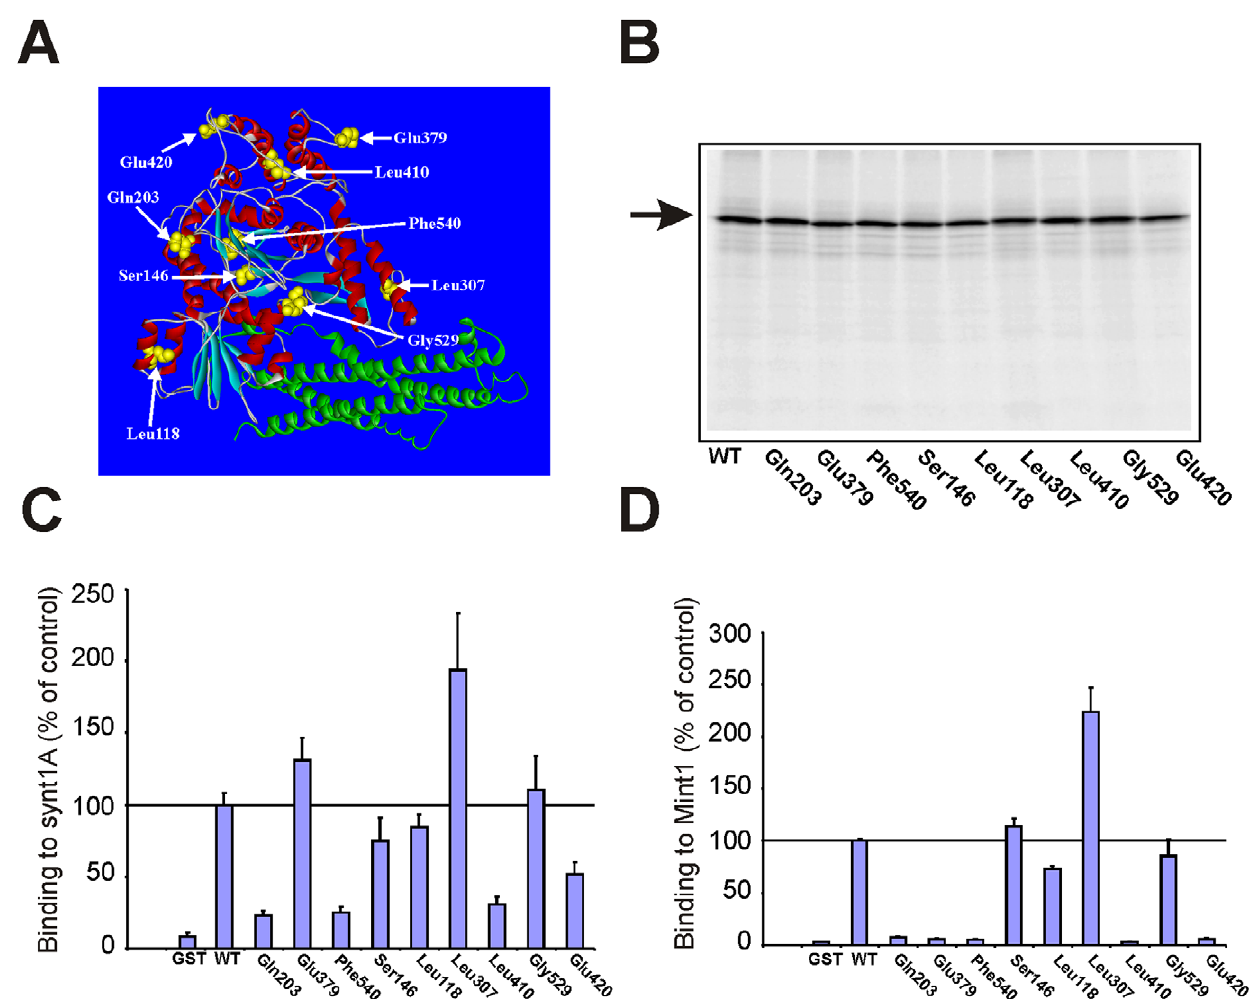
Figure 1. Biochemical phenotype of transposon insertion mutants of Munc18-1. (A) Structure of Munc18-1 indicating the position of the insertion mutations. Nine distinct full-length mutants were created randomly distributed throughout the Munc18-1 protein structure. For each mutant, five amino acids were inserted at the specified location (for the amino acid sequence of each exact insertion see Table 1). Arrows designate the position of the last unchanged amino acid for each insertion mutation. (B) 35 S-radiolabelled Munc18-1 insertion mutants were produced by an in vitro transcription-translation reaction and separated by SDS-PAGE. Amount of protein made for wildtype (Wt) and mutant Munc18-1 were verified by autoradiography as indicated by the arrow. Note that none of these insertion mutations affected protein expression. Radiolabelled Munc18-1 proteins from part B were then assessed for binding to GST-syntaxin (C) and GST-Mint1-MBC (Munc18 binding domain) (D) and compared as a percentage of wildtype (Wt) binding. Despite equivalent levels of protein input the insertion mutations had variable effects on binding to syntaxin and Mint1. Glu379 mutant was of particular interest as it had no effect on syntaxin binding but completely eliminated binding to Mint1. The Ser146 mutant had no effect on binding to either